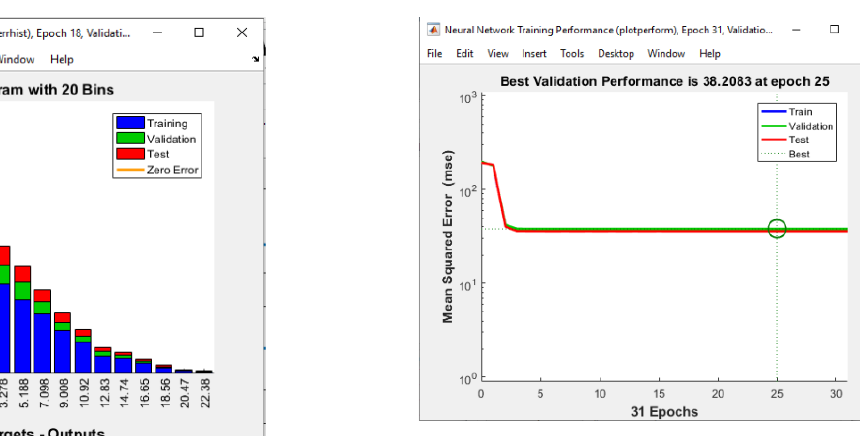
Figure 10 . As you can see in the performance plot, with the epochs the MSE (Mean Square Error) of the ANN has decreased. A well trained ANN should have a very low MSE at the end of the training phase , which in this example, equals to 38.2 at 31 epochs. The meaning of MSE being very small (close to zero) is that the desired outputs and the ANN's outputs for the training set have become very close to each other.